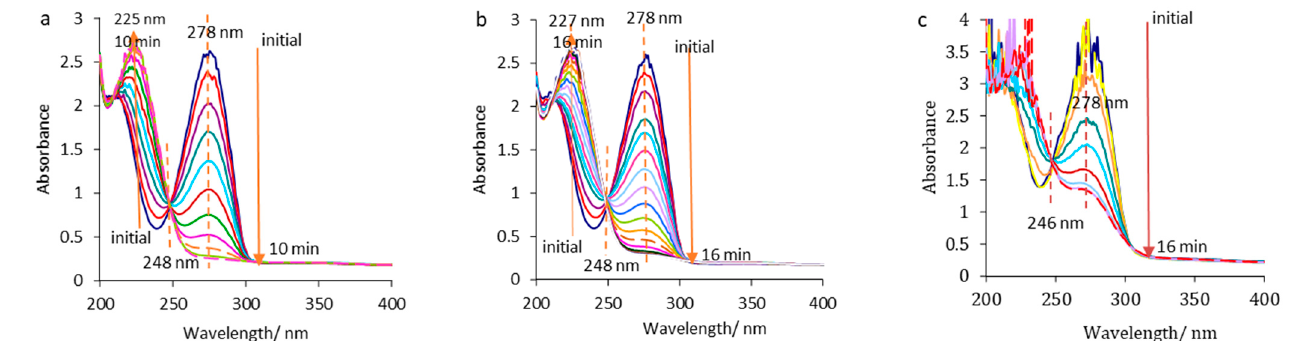
Figure 2. Gemcitabine UV-Vis spectra recorded during electrolysis at a constant current density of 50 mA cm ⁻ 2 : ( a ) in aqueous HCl solution (GCT_HCl); ( b ) in supporting electrolyte, in the absence of essential oil (GCT_SE); ( c ) in supporting electrolyte, in the presence of essential oil (GCT_ESO).